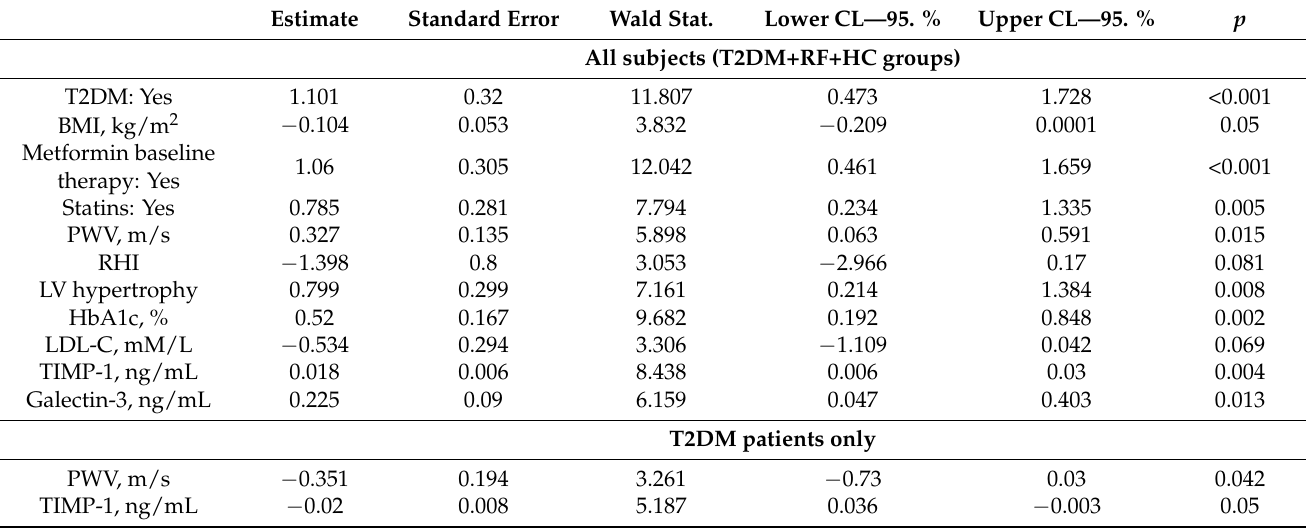
Table 3. Univariate logistic regression analysis of factors associated with cardiac fibrosis as detected by MRI. Estimate